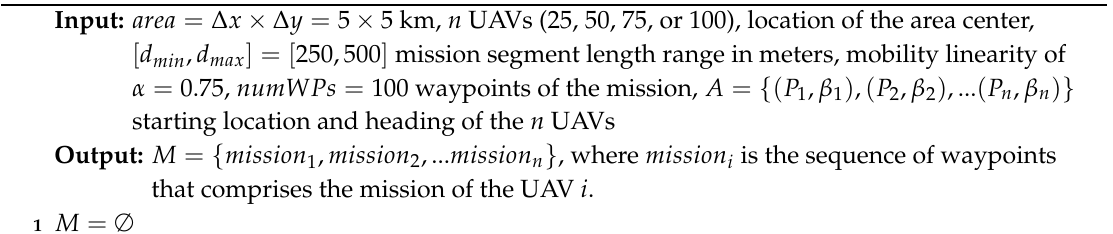
Algorithm 2: R AN M ISSION Gets a Random Mission for n UAVs.